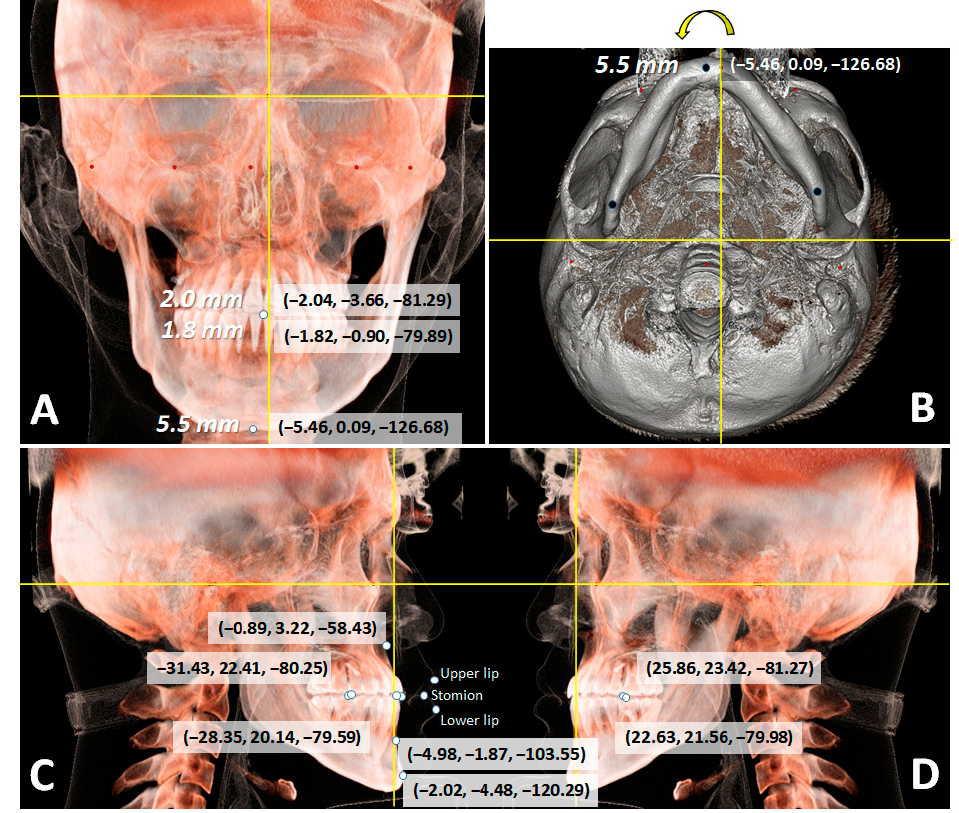
Figure 13. Posttreatment CBCT images using 3-dimensional coordinates. ( A ) Frontal image; ( B ) Sub- mentovertex image (arrow means mandibular yawing); ( C ) Sagittal image (right side); ( D ) Sagittal image (left side).